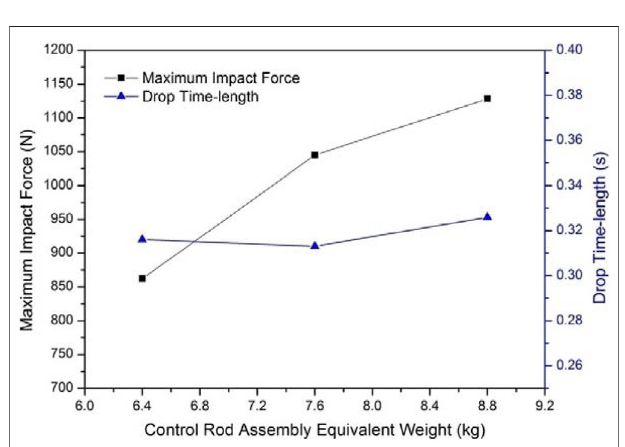
FIGURE 15 | The effects of equivalent weight on the maximum impact force and the drop time-length.